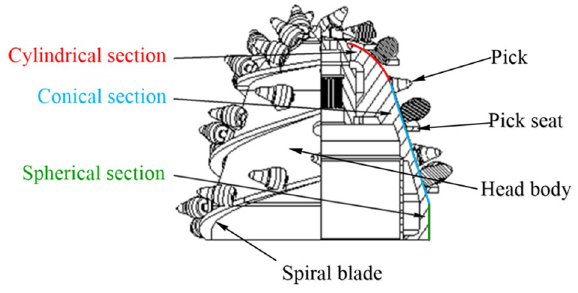
Figure 1. Structure composition of cutting